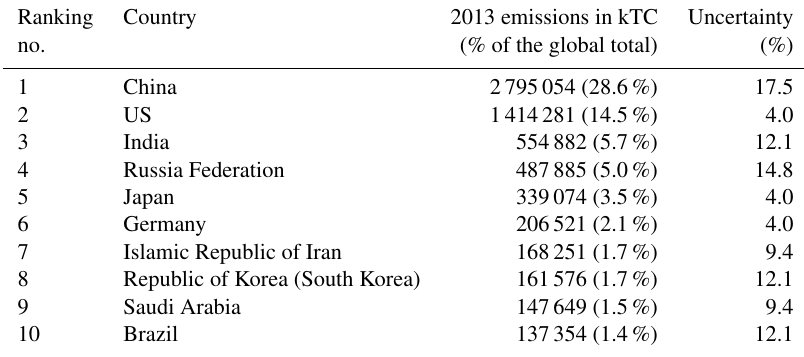
Table 2. Annual uncertainty estimates associated with CDIAC national emissions estimates. The uncertainty estimates were made following the method described by Andres et al. (2014). The national total emissions for the year 2013 were taken from Boden et al.